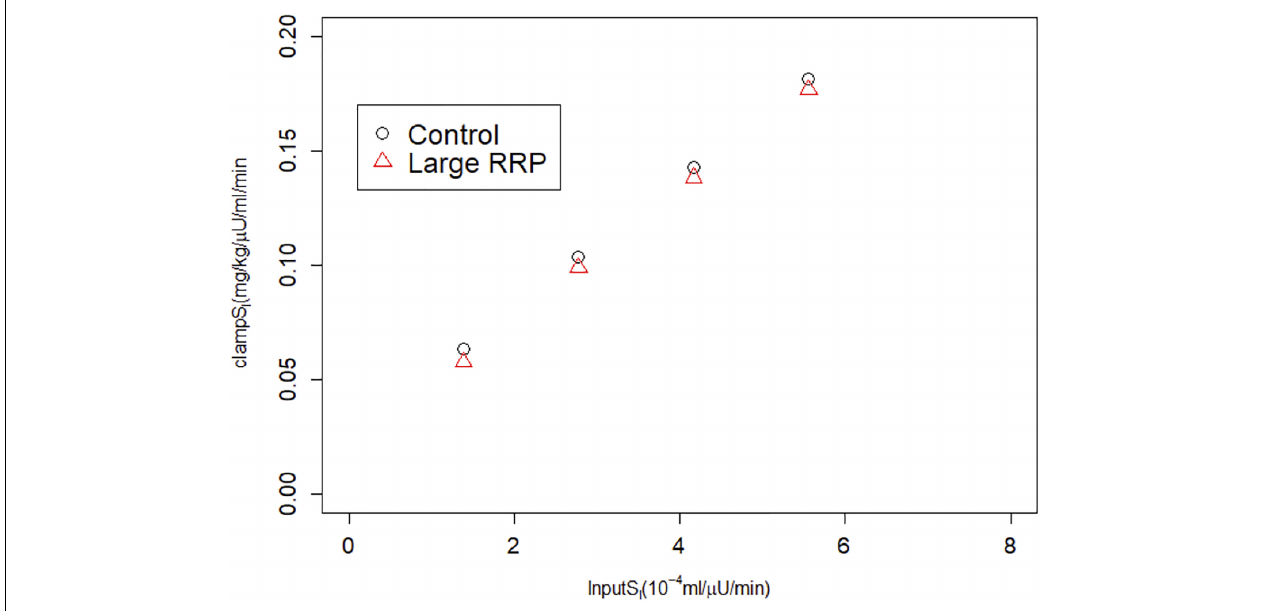
FIGURE 5 | HIEC correctly recovers the assumed S I independent of RRP size and hence AIR. Cases correspond to Figure 3 .